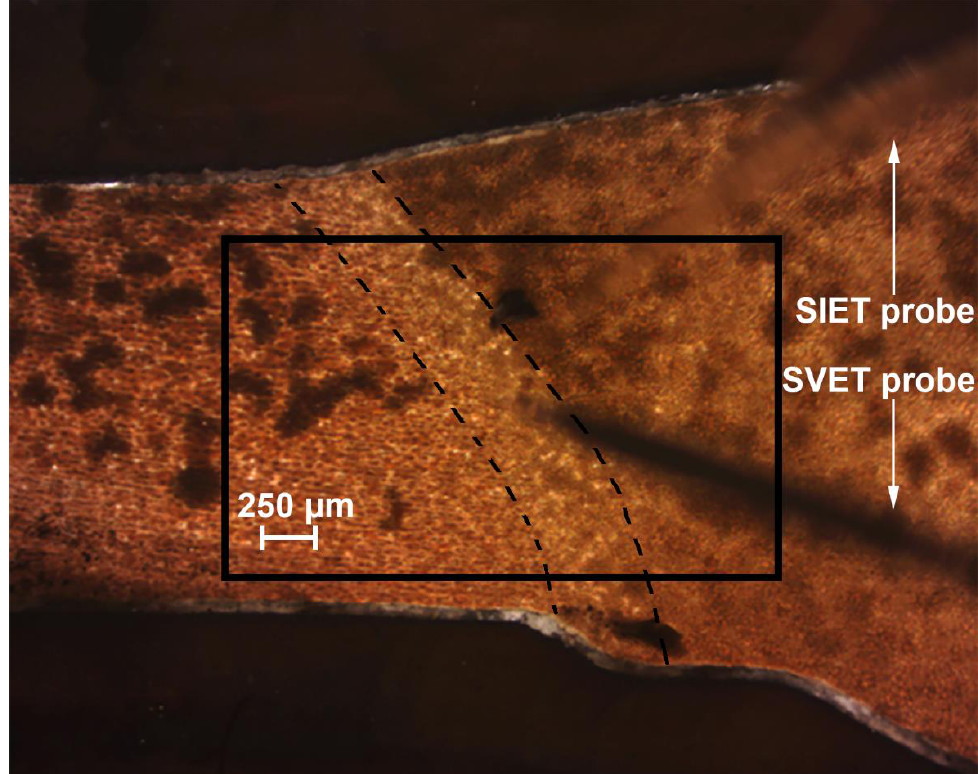
Figure 7. The optical image of the investigated welded joint area of the 1579 aluminium alloy sample with composite polymer-containing coating after SVET and SIET experiments (after 500 h of specimen exposure). The investigated area is outlined by a frame and the border of the weld interface of the sample is marked by a dotted line.